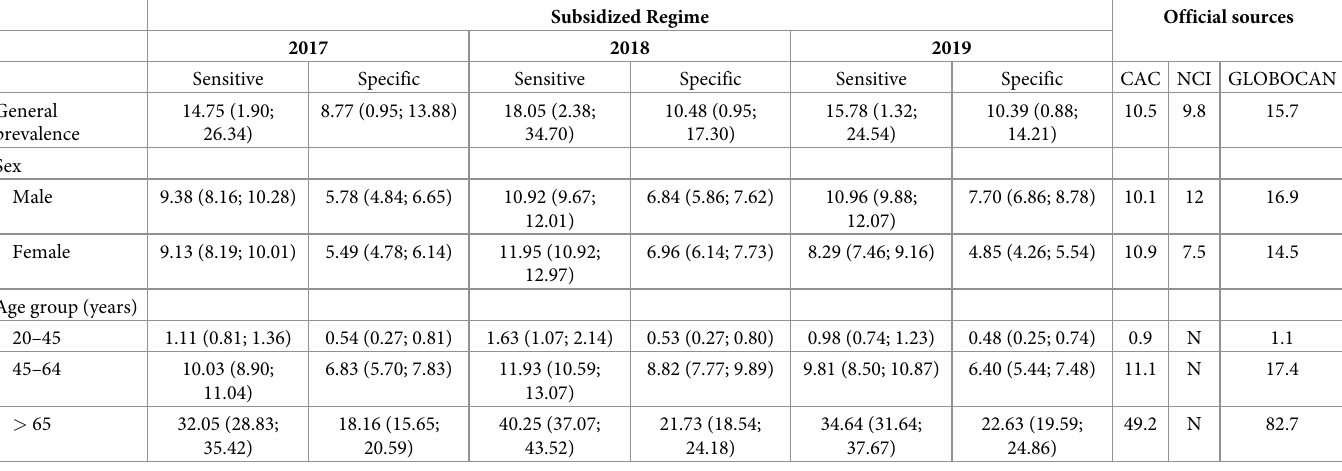
Table 2. Comparison between the prevalence rates identified in this study versus official aggregated data sources for 2017, 2018 and 2019 in the subsidized